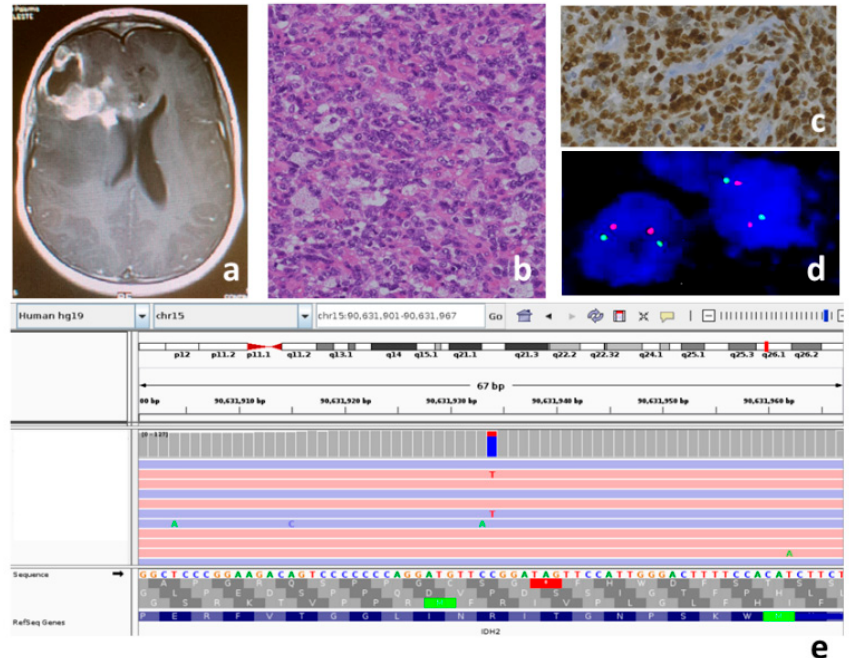
Figure 1. Patient P3, IDH mutant pHGG: ( a ) MRI T1 contrast-weighted; right frontal lesion, unevenly capturing contrast, extensive periwound edema; the tumor is in contact with the frontal horn of the right lateral ventricle; ( b ) medium-sized atypical cells and intralesional histiocytes, hematoxylin and eosin, original magnification 20×; ( c ) positive nuclear immunostaining for p53 protein as indirect expression of TP53 mutation, original magnification 20×; ( d ) no 1p36 deletion in dual color FISH analysis (two orange and two red signals in each nucleus); ( e ) the variant c.419G>A p.Arg140Gln in exon 4 of the IDH2 gene (NM_002168) is read in both the strands 119X (94X in G ref allele and 23X in T alt allele).